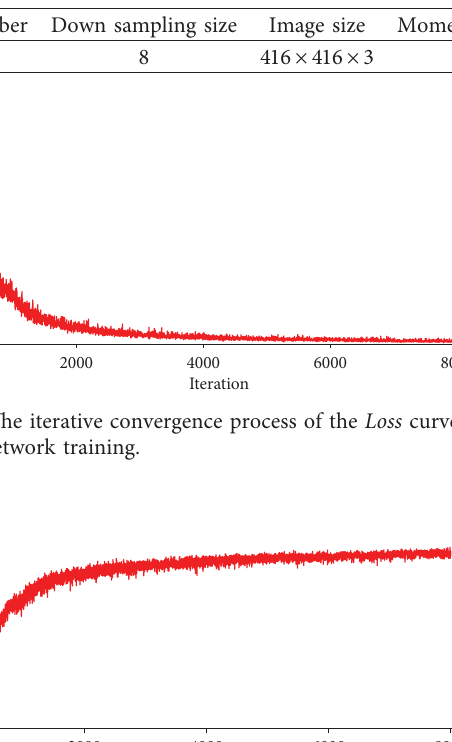
Table 3: The same training parameters for our improved RDCNN and YOLOv2/v3.